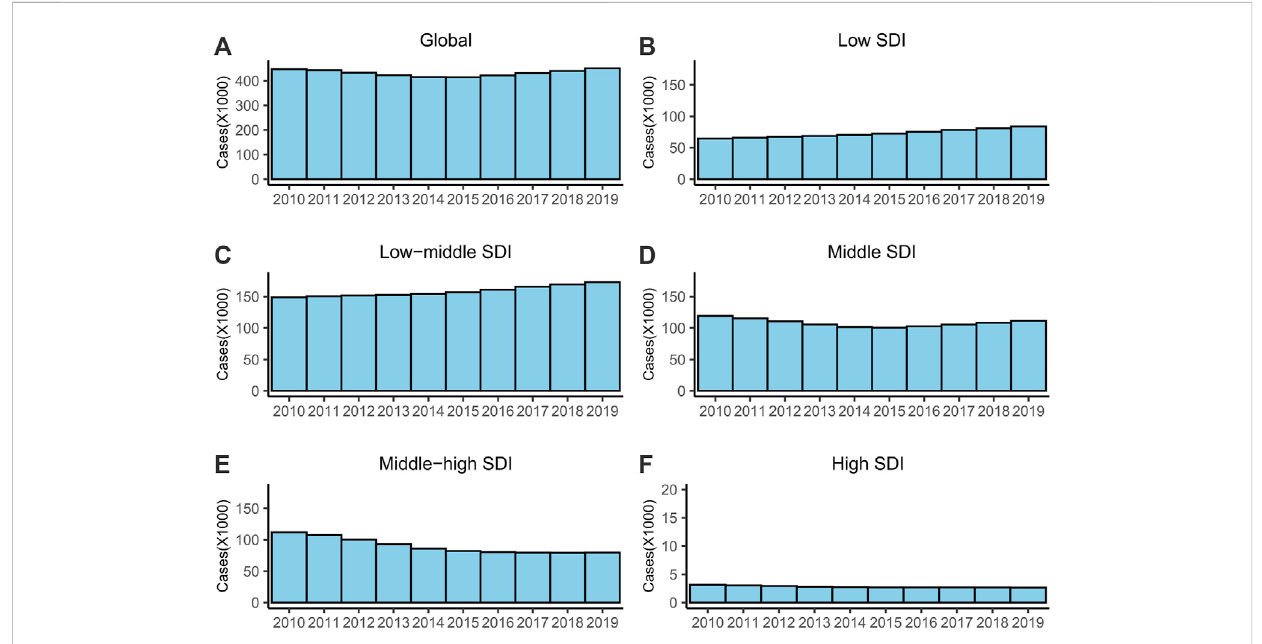
The cases of MDR-TB from 2010 to 2019. (A) Global, (B) low SDI regions, (C) low-middle SDI regions, (D) middle SDI regions, (E) middle-high SDI regions and (F) high SDI regions. Abbreviations: MDR, multidrug-resistant; TB, tuberculosis; SDI, socio-demographic